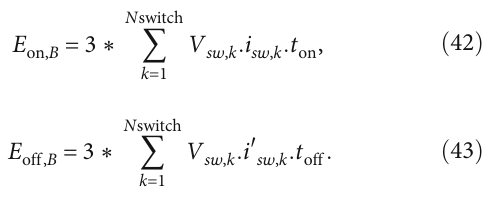
and S . (c) Output line voltage of 3 ϕ 3 4